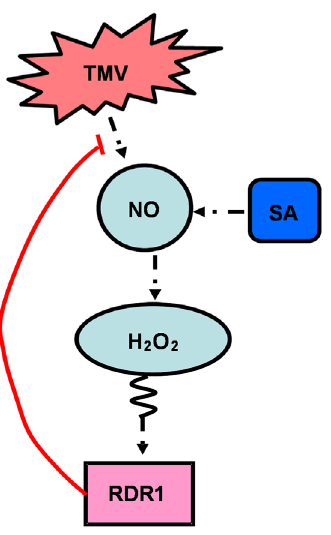
Figure 9. A hypothetical model for the role of H 2 O 2 and NO in the induction of RDR1. Black dashed lines indicate positive interactions; red solid line indicates negative regulation.